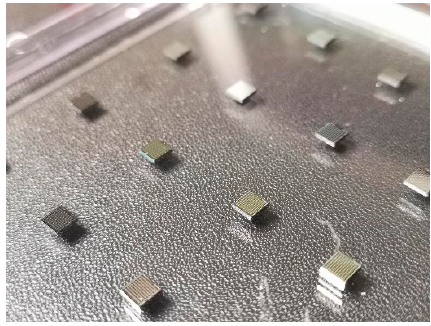
Figure 3. Fabricated array of Micro-Electro-Mechanical System (MEMS) hydrophone sensors.